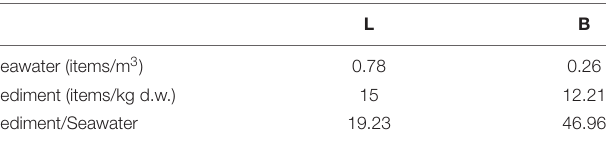
TABLE 2 | Average microplastic abundances in seawater and sediment sample in this